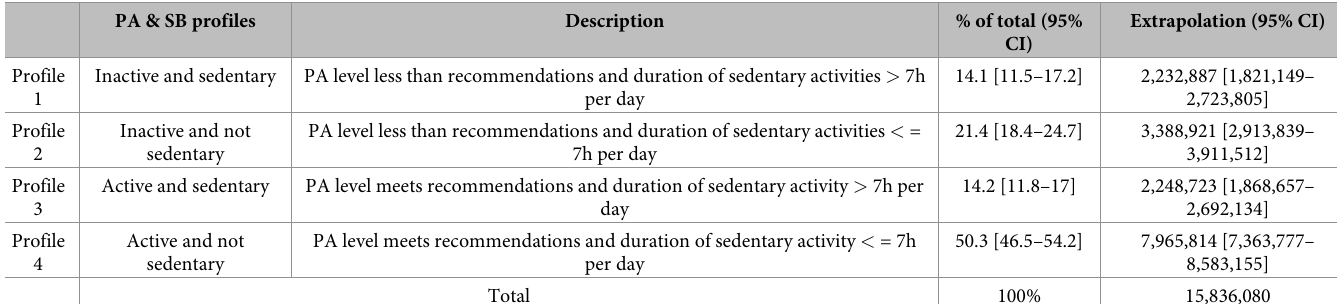
Table 9. PA & SB profiles of the 55–74 age group.